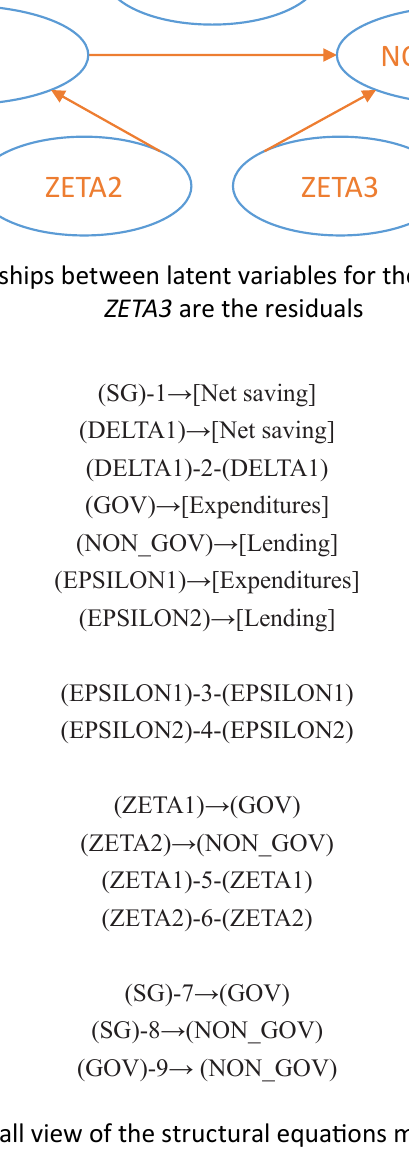
Figure 4. Overall view of the structural equations model for both